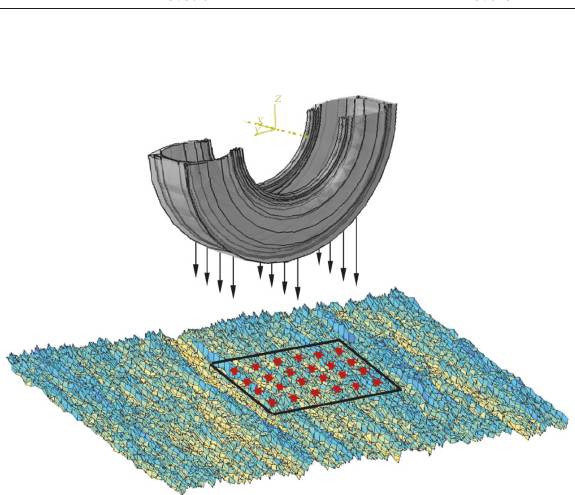
Figure 7: Three-dimensional contact model of tire and rough road surface.